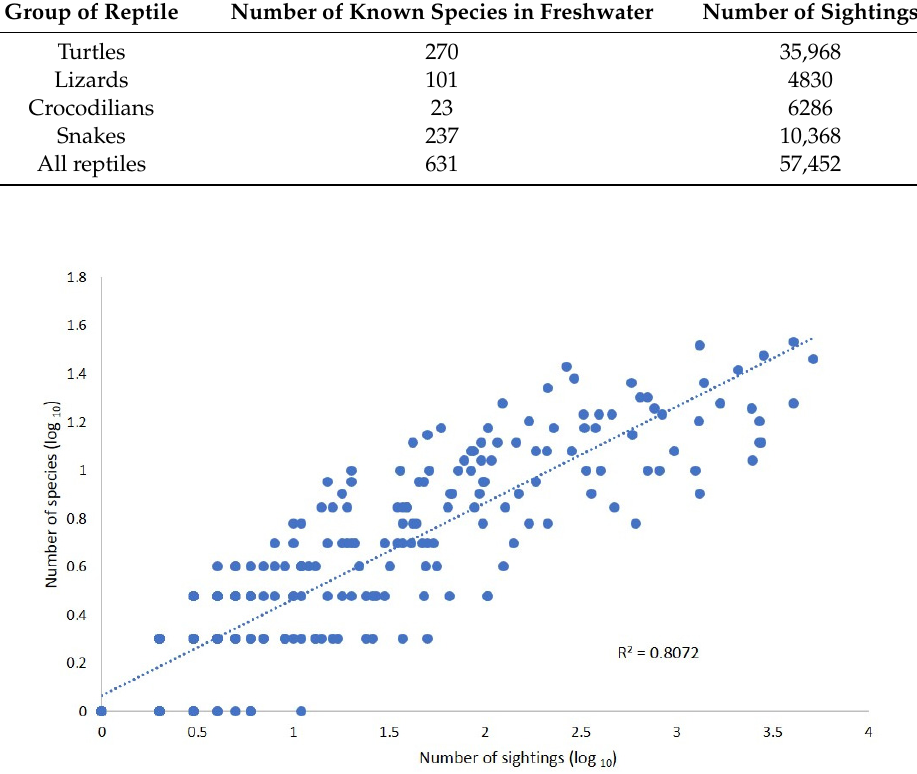
Figure 2. The relationship between the number of sightings made and number of species recorded within an ecoregion. Each point is a Freshwater Ecoregion of the World (FEOW) region ( n = 265). Turtles were the most sighted group (Table 1), but almost a third (29.4%) of the turtle sightings